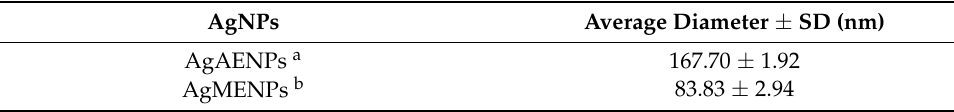
Table 5. The diameter size of AgAENPs dan AgMENPs.